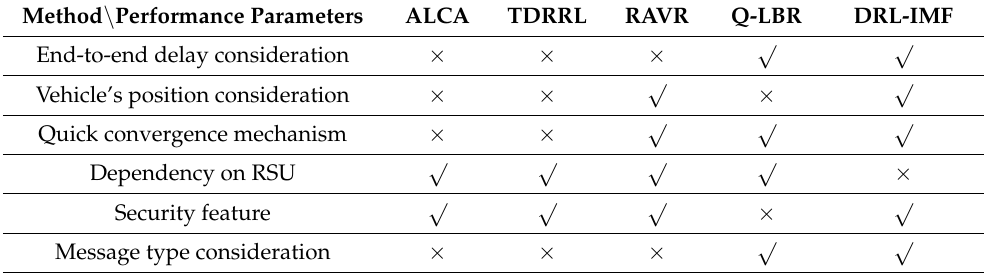
Table 3. Optimization performance